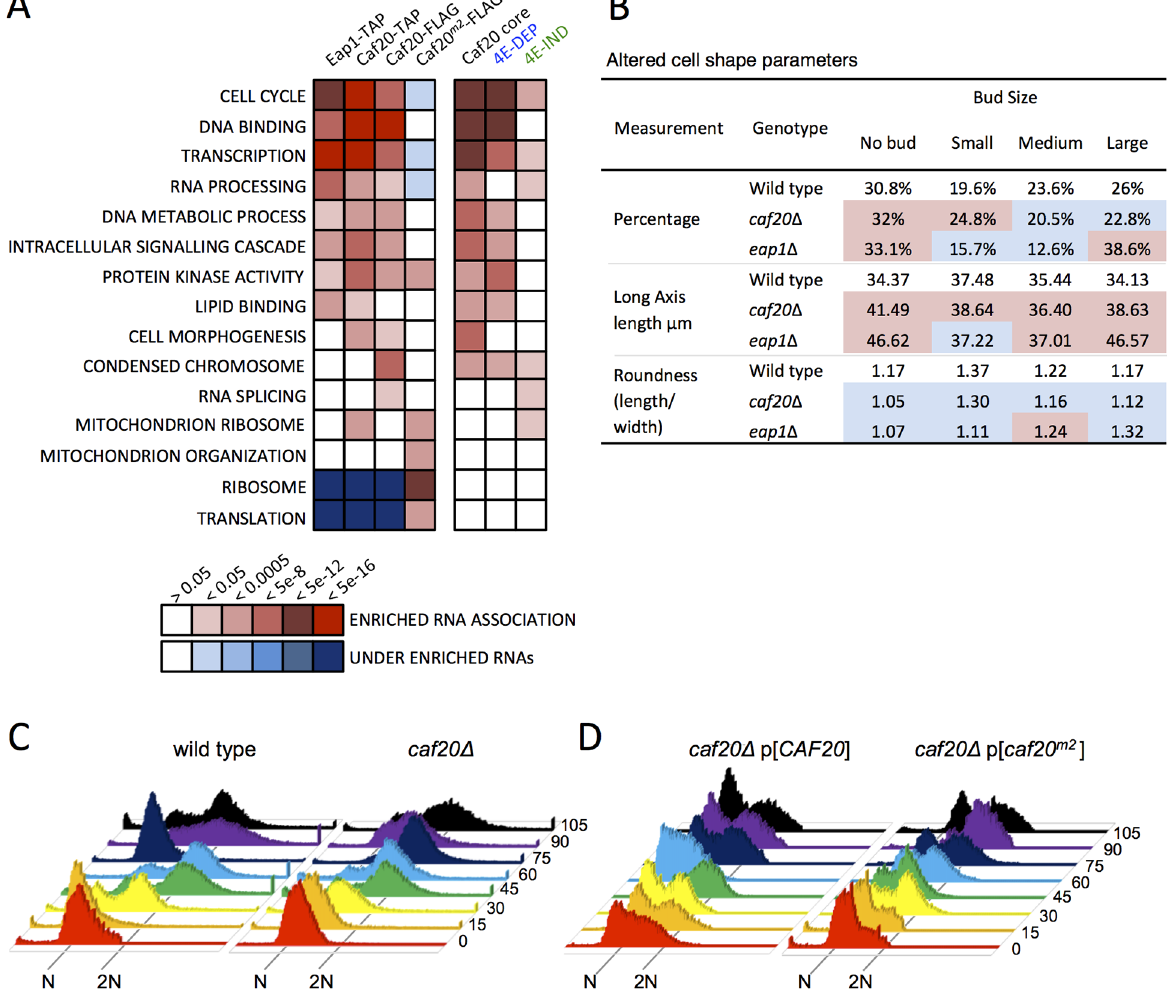
Fig 5. 4E-BP-bound mRNAs enrich cell cycle and transcription factors. A. Functional GO class analysis of mRNAs associated with the 4E-BPs by RNA- seq. Over/underrepresentation colours depict FDR significance as per the key. Only a representative selection of the significant functional categories is shown. B. Summary of morphology changes noted within the Saccharomyces cerevisiae Morphological database (SCMD; http://yeast.gi.k.u-tokyo.ac.jp/ datamine/) for 4E-BP deletion strains. Red/blue shading indicate over/under enrichment compared to wild type cells. C. D. Cell cycle progression defects in caf20 mutants. Flow cytometry analysis of DNA content using Sytox Green staining is shown at the indicated times (min) following release from alpha factor arrest for C. wild type and mutated cells, and D. plasmid complemented mutant cells.